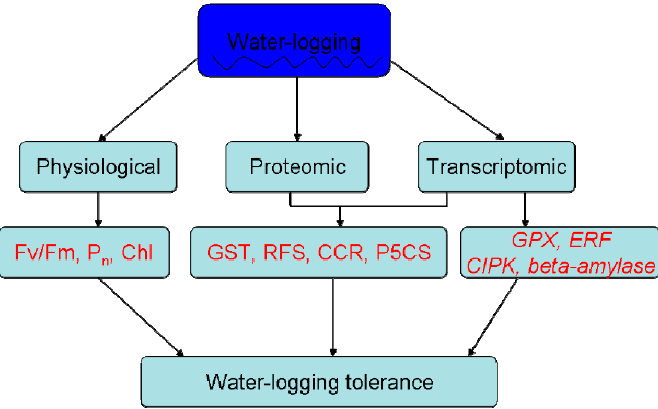
Figure 8. A schematic model for waterlogging stress responses in alfalfa plants.